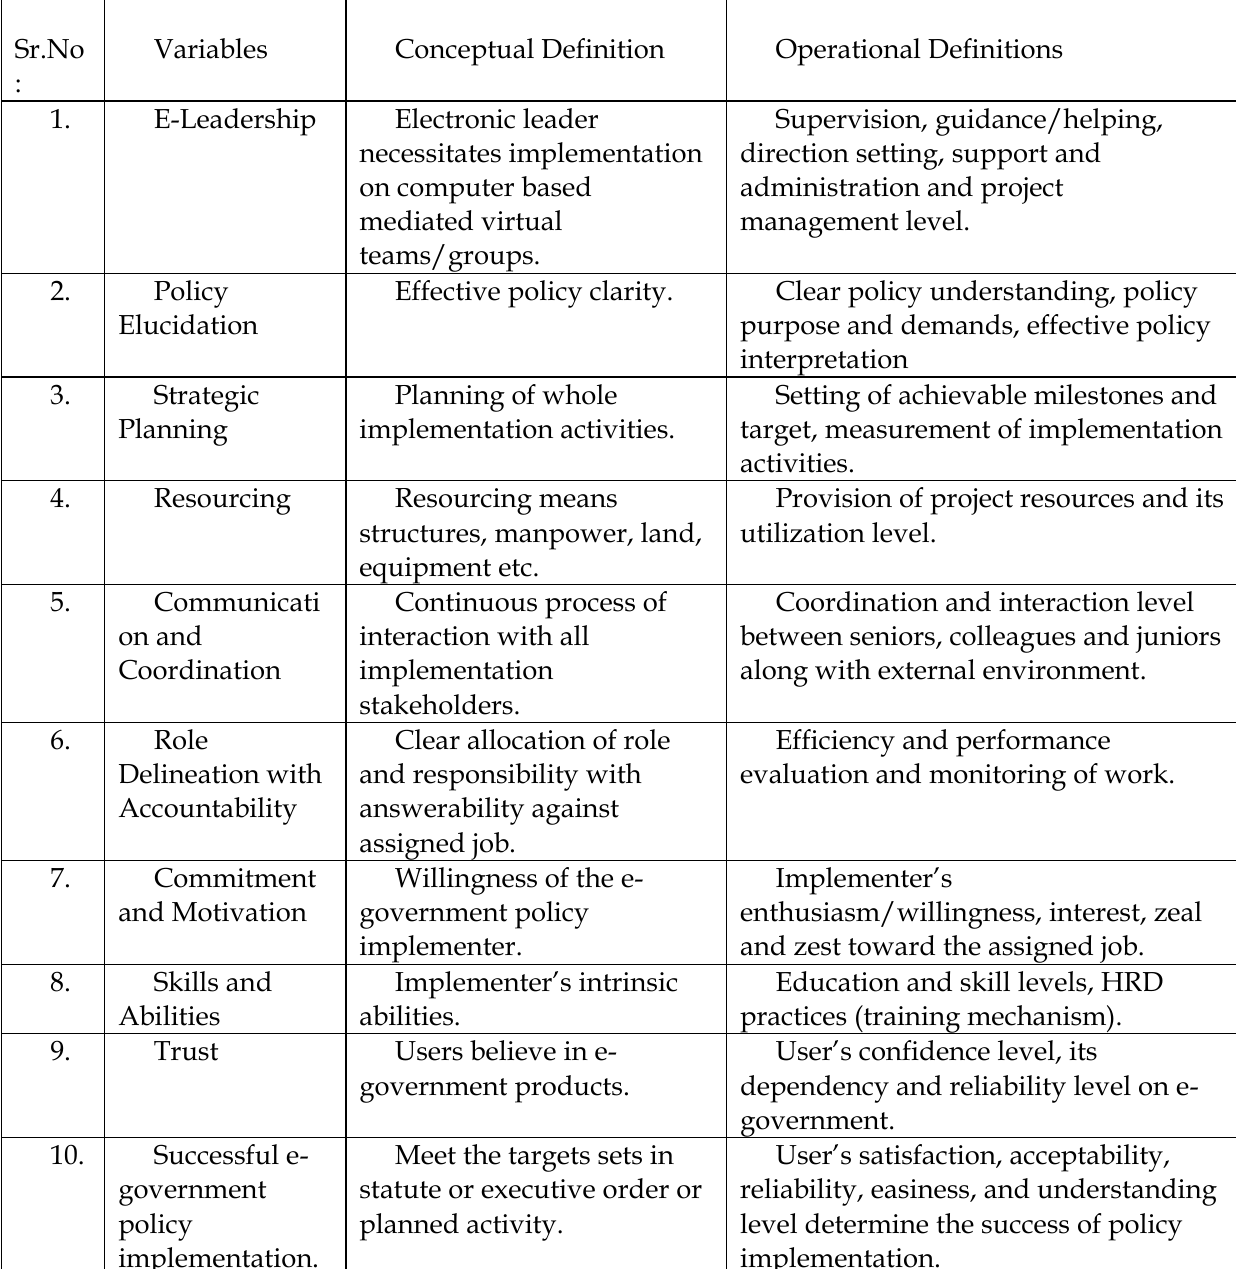
Table 1: Conceptual and Operational Definition of Variables